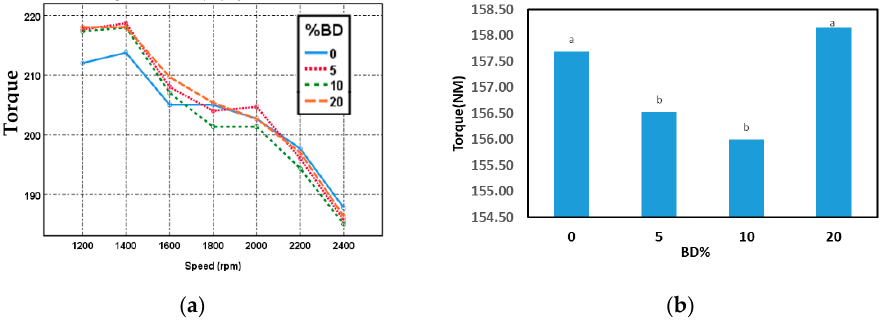
Figure 5. ( a ) T vs. S at 100% load; ( b ) mean values of total data of T for different speeds and loads. The letters a-d inside the diagram indicate significant differences ( P ≤ 0.05).